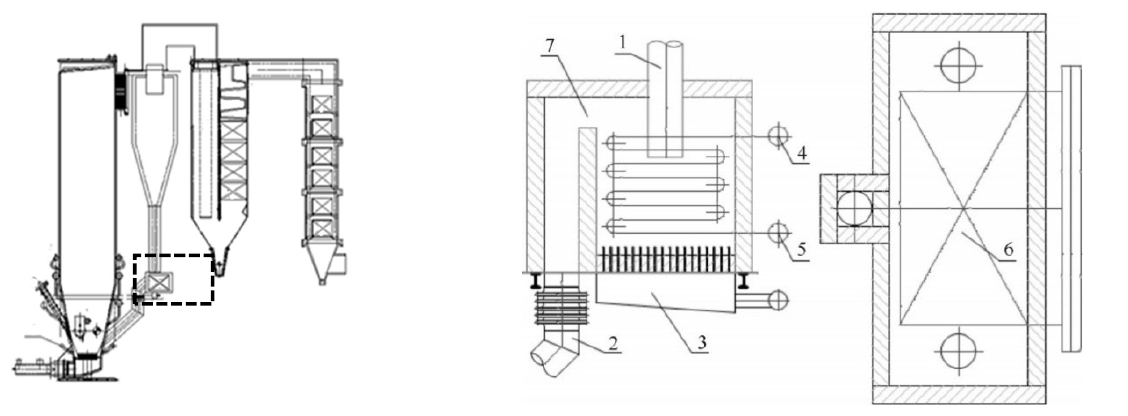
Figure 1. The figuration of EHE: 1—ash inlet 2—ash back 3—equalizing air chamber 4—high temperature superheater outlet header 5—high temperature superheater inlet header 6—high temperature superheater serpentine tube 7—ash back overflow hole.